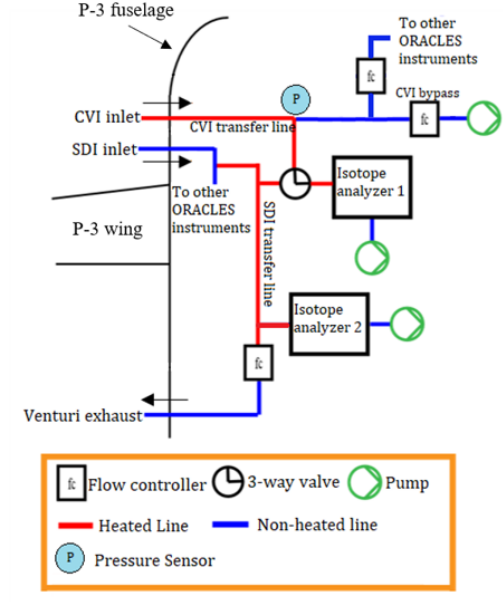
Figure 3. Simplified schematic of the WISPER system on the P-3 Orion aircraft. Arrows show direction of airflow. Both isotope an- alyzers are Picarro-brand cavity ring-down spectrometers. The first analyzer (WIA1) samples off the transfer lines of either a solid differ inlet (SDI) or a counterflow virtual impactor (CVI) inlet, sampling total water or cloud condensed water respectively. The second ana- lyzer (WIA2) samples from the SDI only. Flow in the SDI transfer line is maintained by low pressure from a venturi exhaust. Flow in the CVI transfer line is maintained with a vacuum pump. For each analyzer, air is pulled from the transfer line into the analyzer with a vacuum